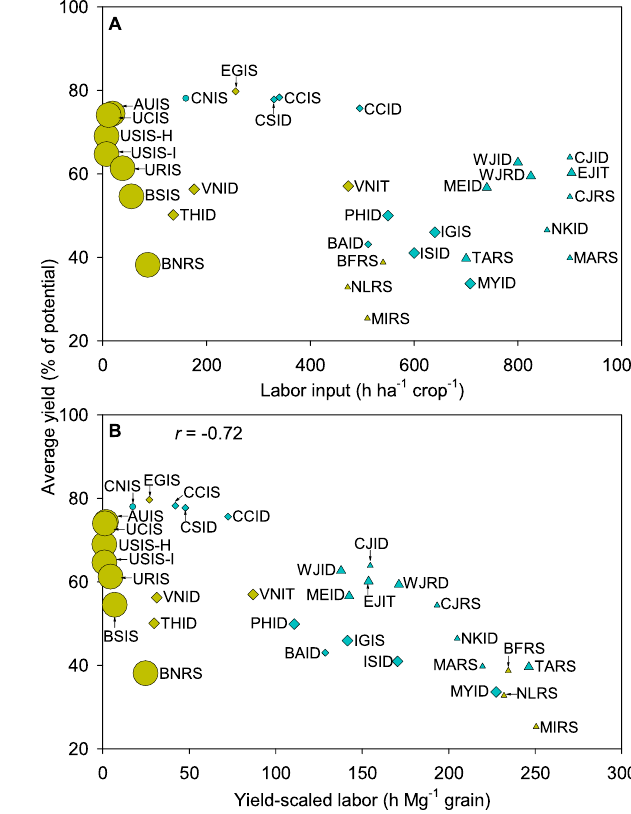
Fig. 4 Yield and labor input across 32 rice cropping systems. Panels show average rice yield (expressed as percentage of yield potential) versus A labor input per hectare and B yield-scaled labor. Symbols are used to distinguish systems with high (circle), intermediate (diamond), and low (triangle) level of mechanization. Symbol color indicates the predominant establishment method in each system: transplanting (blue) or direct seeding (yellow). Symbol size is proportional to the average fi eld size in each system. Pearson ’ s correlation coef fi cient ( r ) is shown only when the association between variables is signi fi cant (two-tailed Student ’ s t -test; p < 0.01; n = 32 cropping systems). Cropping system codes are shown in Fig. 1. Data are provided in Source